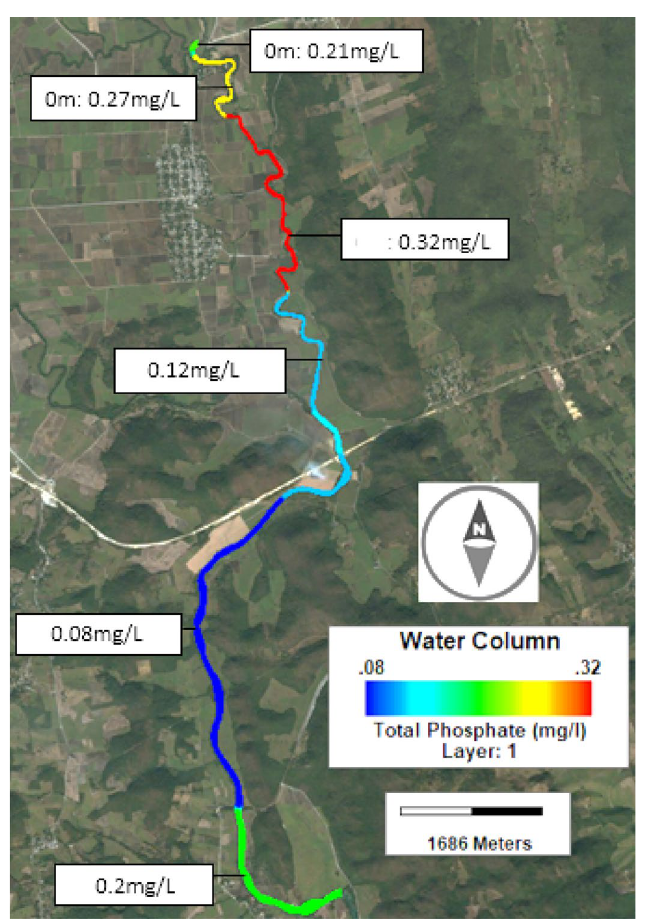
Figure 6. Initial concentration for the phosphates, established by zones according to the samples in the field. Similar initializations, were carried of for NO 3 -N and DO. This figure was generated using the post-processing visualization tool of the EFDC Explorer (https:// www. eemod eling system.